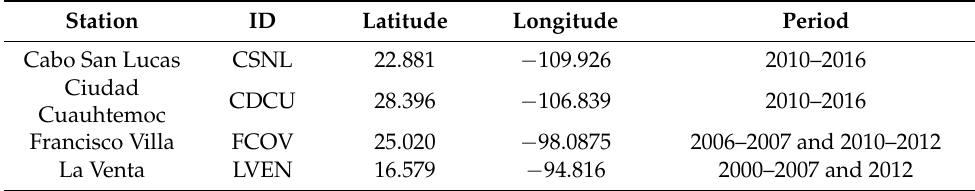
Table 1. Description of measurement